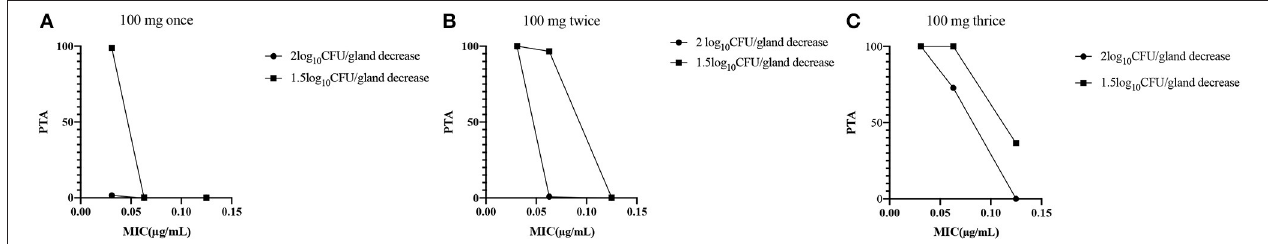
FIGURE 6 | (A) Fractional attainment of the 2log 10 CFU/gland decrease for S. aureus (•) and 1.5 log 10 CFU/gland decrease for S. aureus ( (cid:4) ) for the 1-dose (100 mg/gland)/24h administration. (B) Fractional attainment of the 2log 10 CFU/gland decrease for S. aureus (•) and 1.5log 10 CFU/gland decrease for S. aureus ( (cid:4) ) for the 2-dose (100 mg/gland)/24h administration. (C) Fractional attainment of the 2log 10 CFU/gland decrease for S. aureus (•) and 1.5log 10 CFU/gland decrease for S. aureus ( (cid:4) ) for the 3-dose (100 mg/gland)/24h administration.